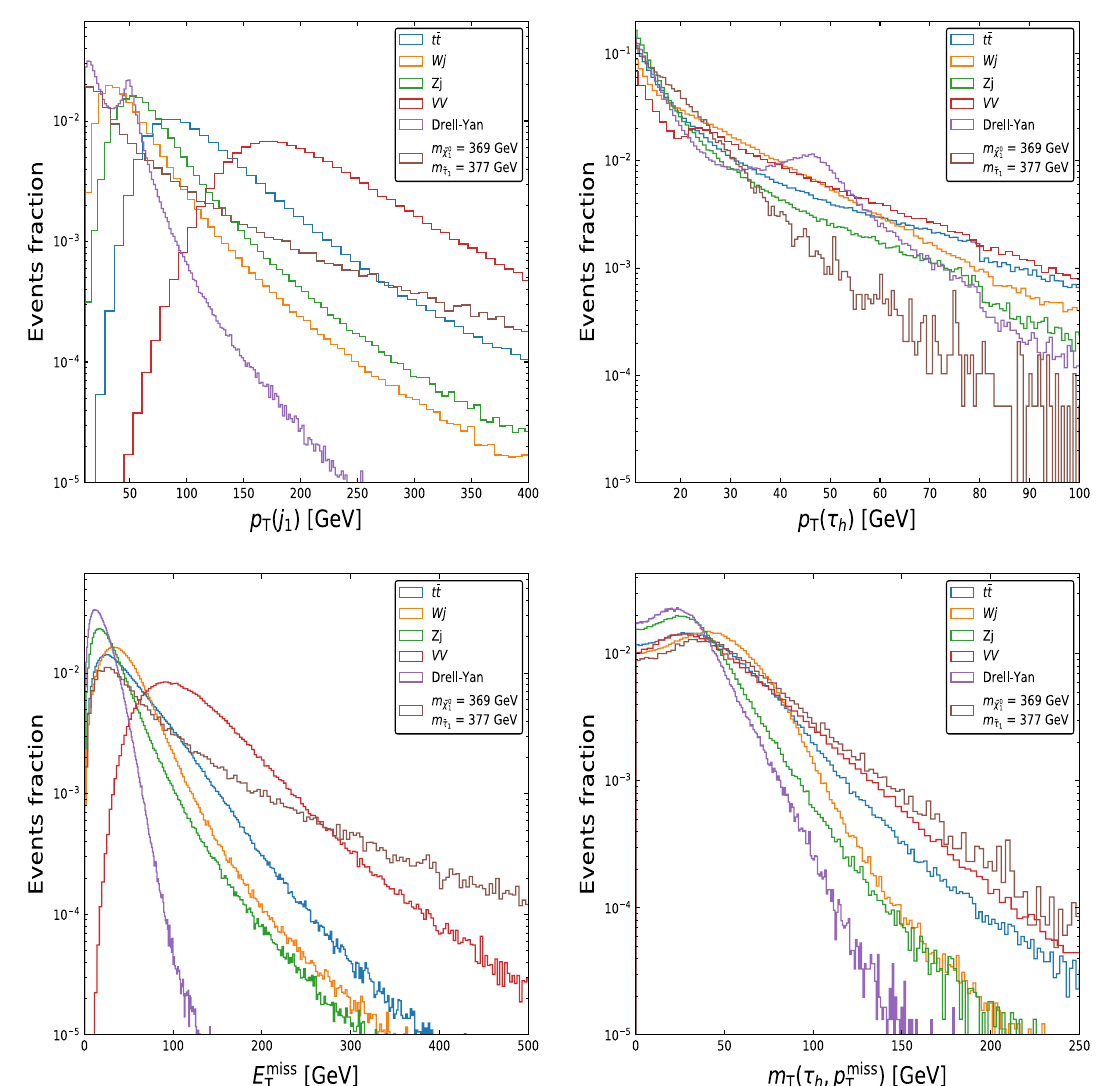
and m T τ of the signal and backgrounds at 27 TeV HE-LHC. The benchmark point T h